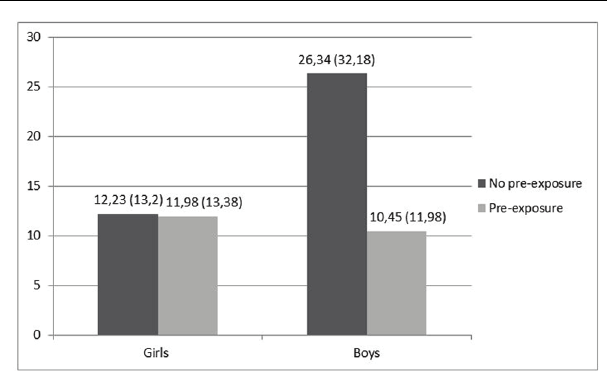
FIGURE 1 |The interaction of pre-exposure to temptation and gender on consumption (grams